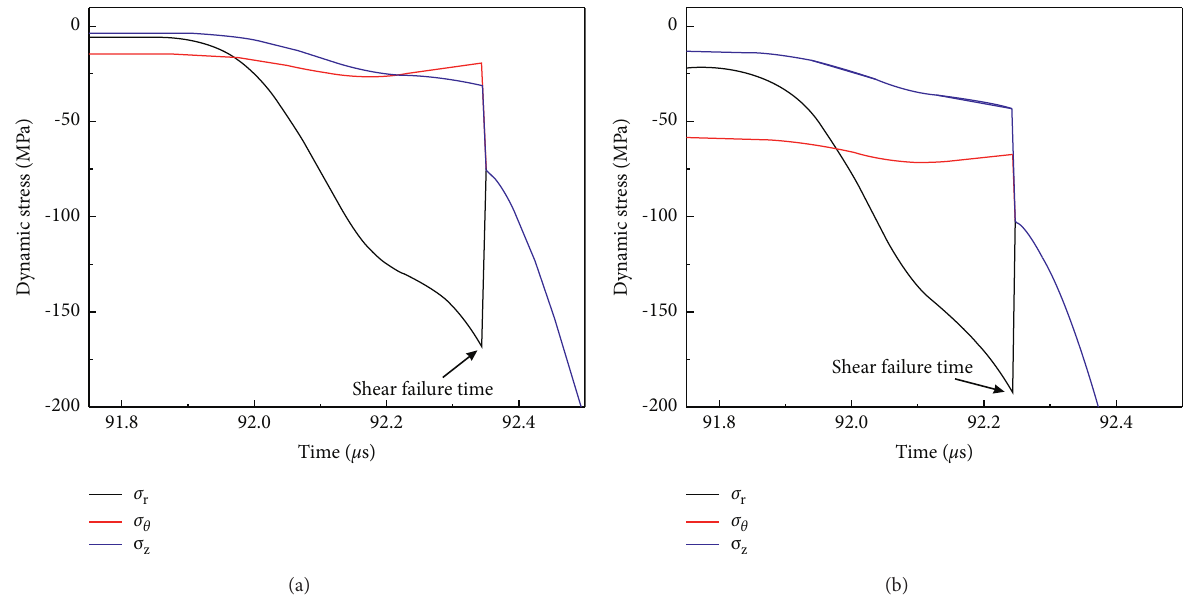
Figure 13: History curves of three principal stress σ